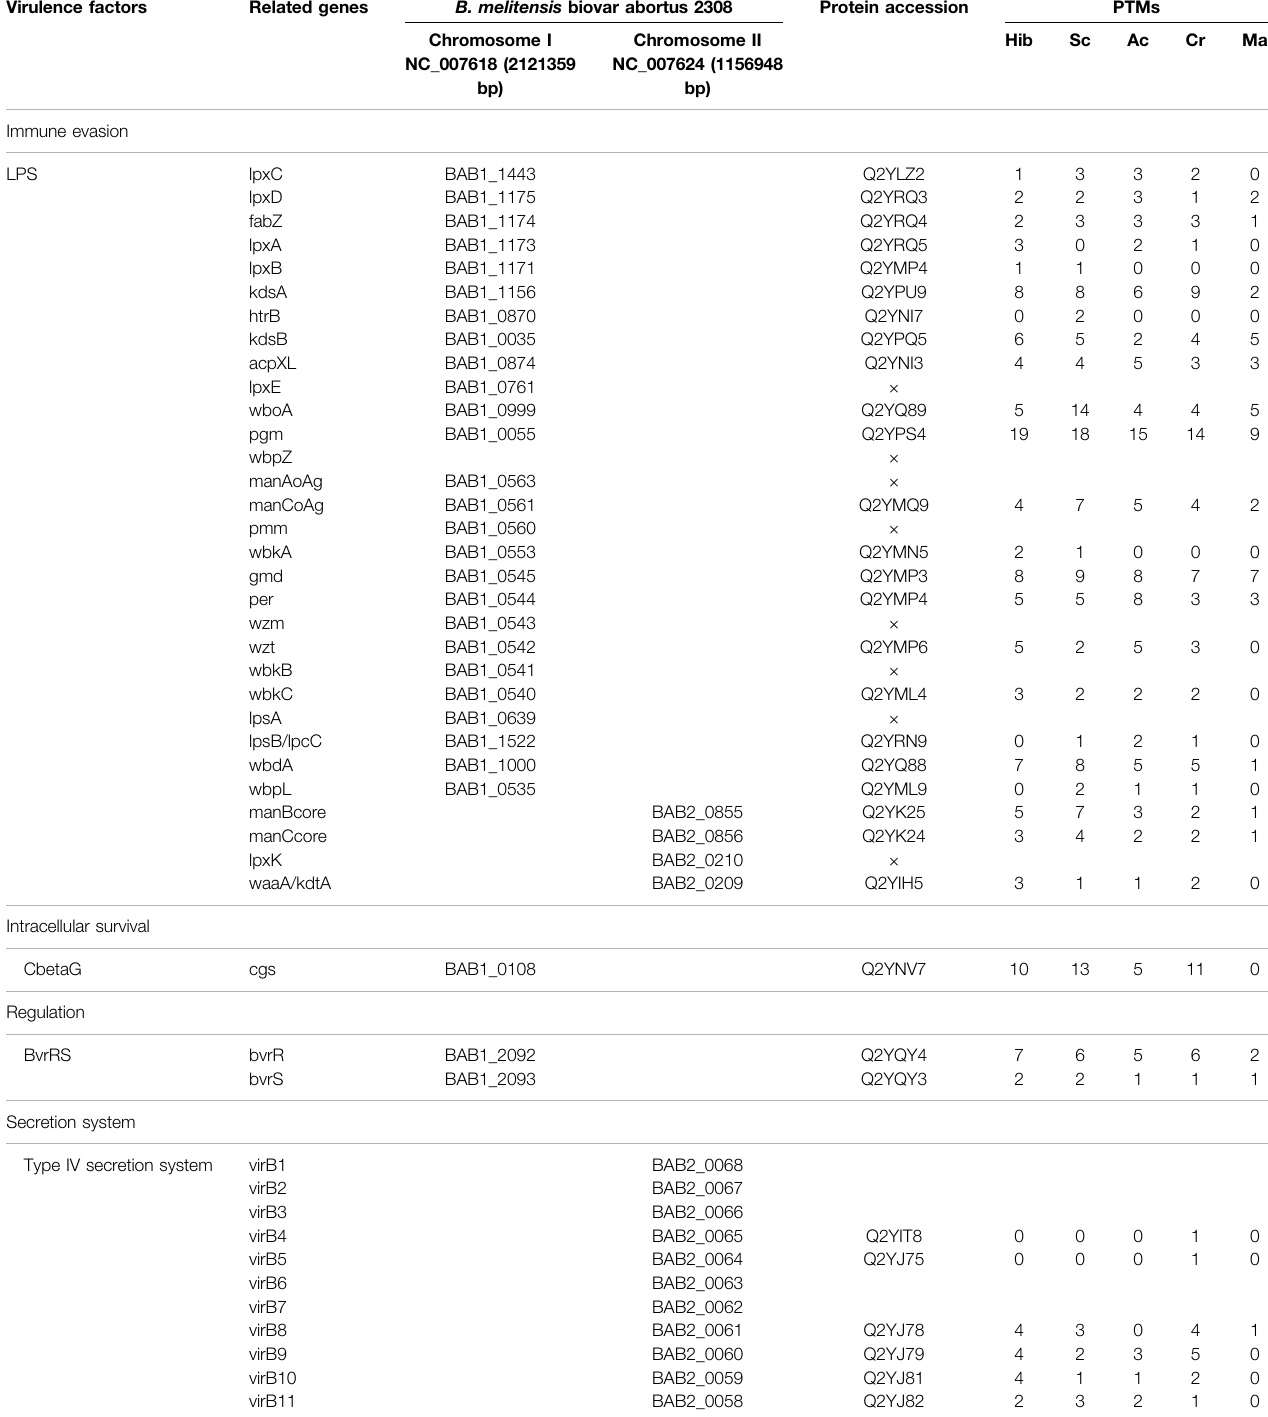
TABLE 1 | Modi fi cation of classical virulence factors in Brucella